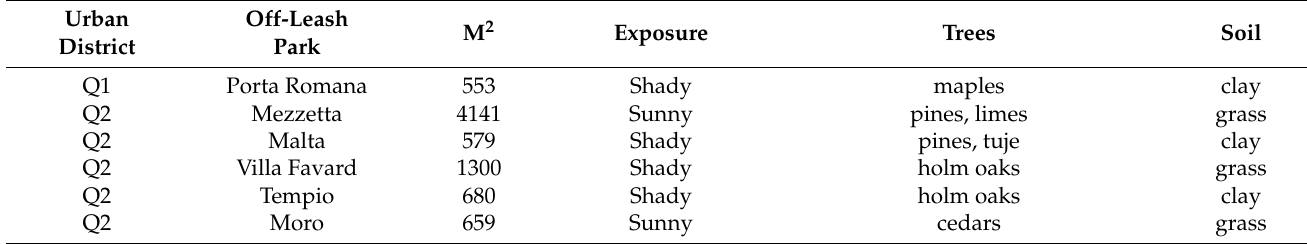
Table 1. Main characters of the off-leash parks located in different urban districts where samples were collected. Urban